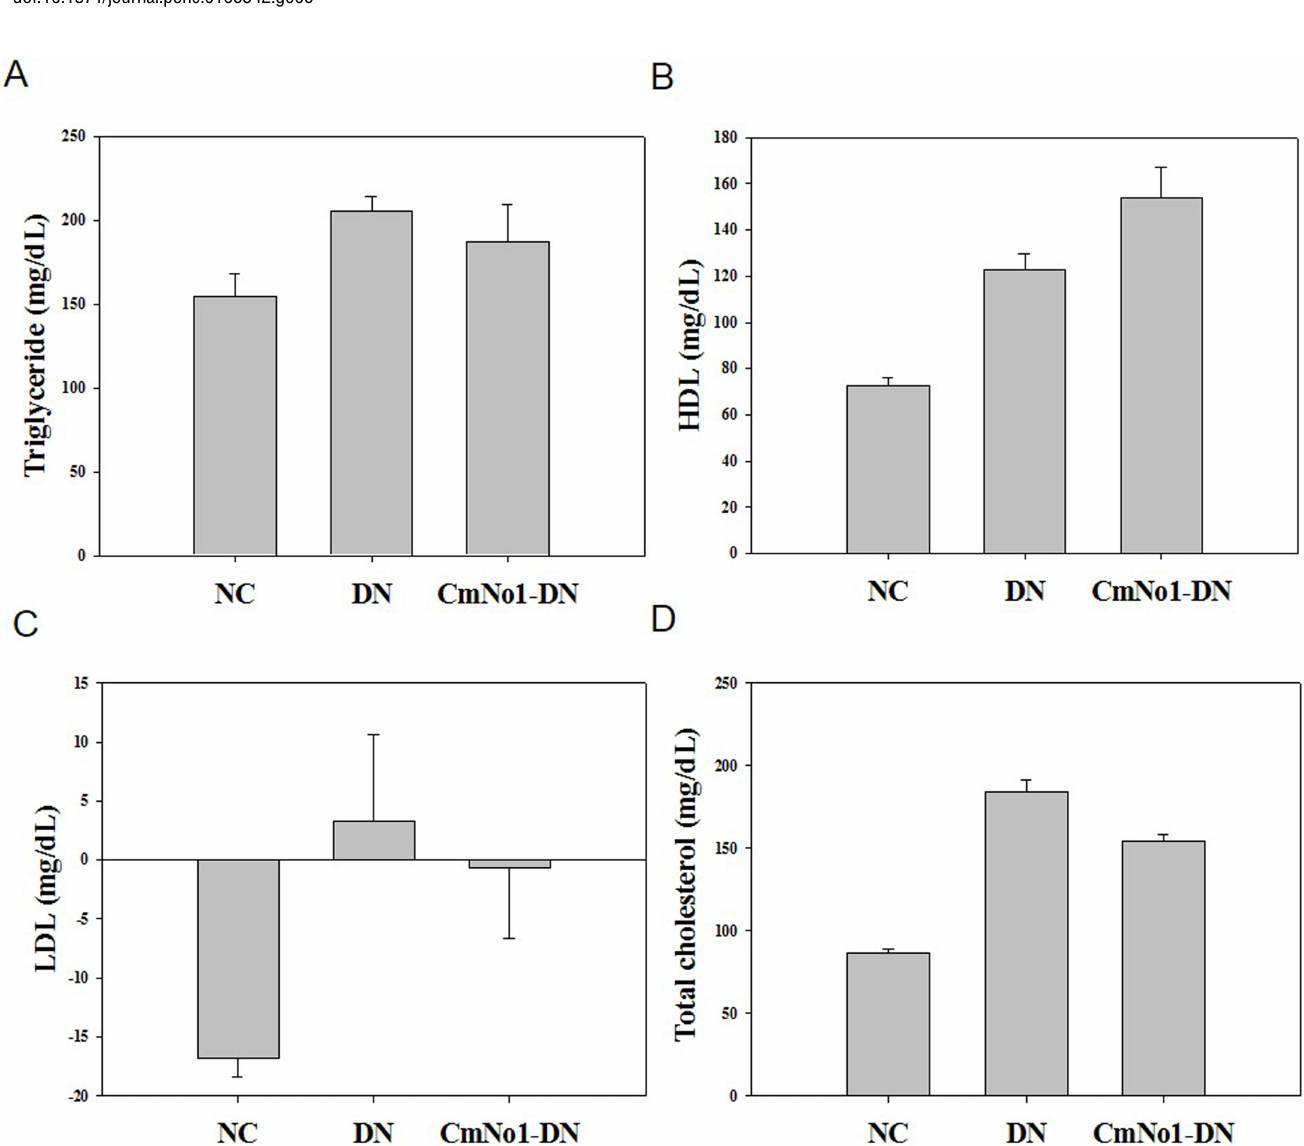
Fig 7. Effect of CmNo1 on metabolic disturbances after 8 week treatment. (A) Triglyceride(B) HDL (C) LDL (D) Total cholesterol. NC: Normal control; DN: Diabeticnephropathy; CmNo1-DN: Diabeticnephropathygroup mice treated with Cordyceps militaris No1. HDL: High-density lipoprotein; LDL: low-density lipoprotein.